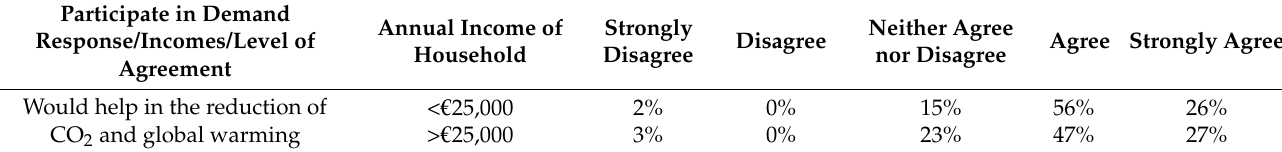
Table 5. Consumers’ interest in the reduction of climate change impact and their level of income.